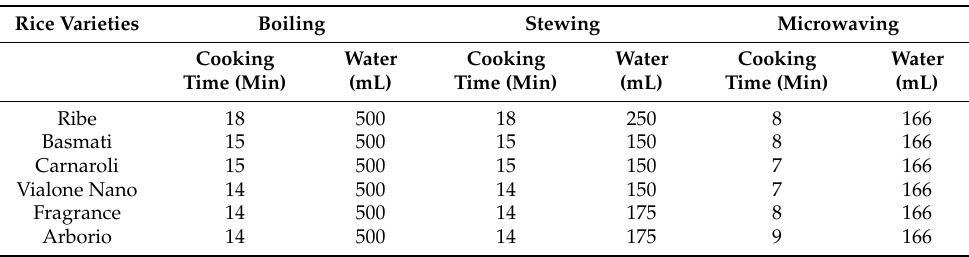
Table 2. Cooking time (min) and water (mL) used for each rice variety for the three cooking methods (boiling, stewing and